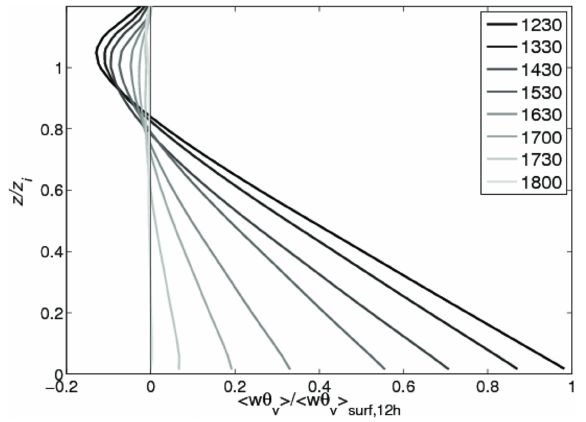
Figure 5. Vertical profiles of the buoyancy flux normalized by the surface buoyancy flux at 12:00UTC according to the normalized height z/z i